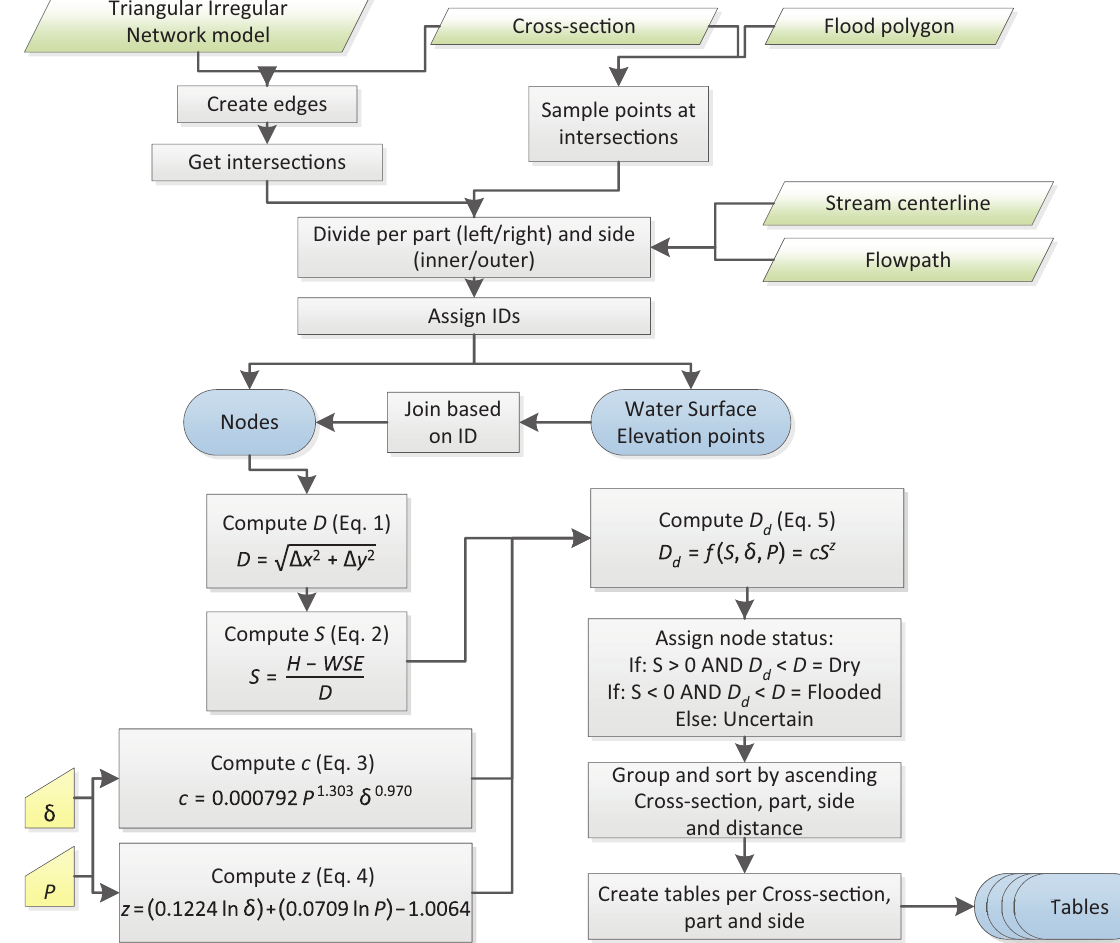
Figure 3. Workflow for preparing data and tables used in the algorithm. Main inputs are: modeled flooded area, TIN model representing the topography, and CS, stream centerline, and flowpath used in the hydraulic